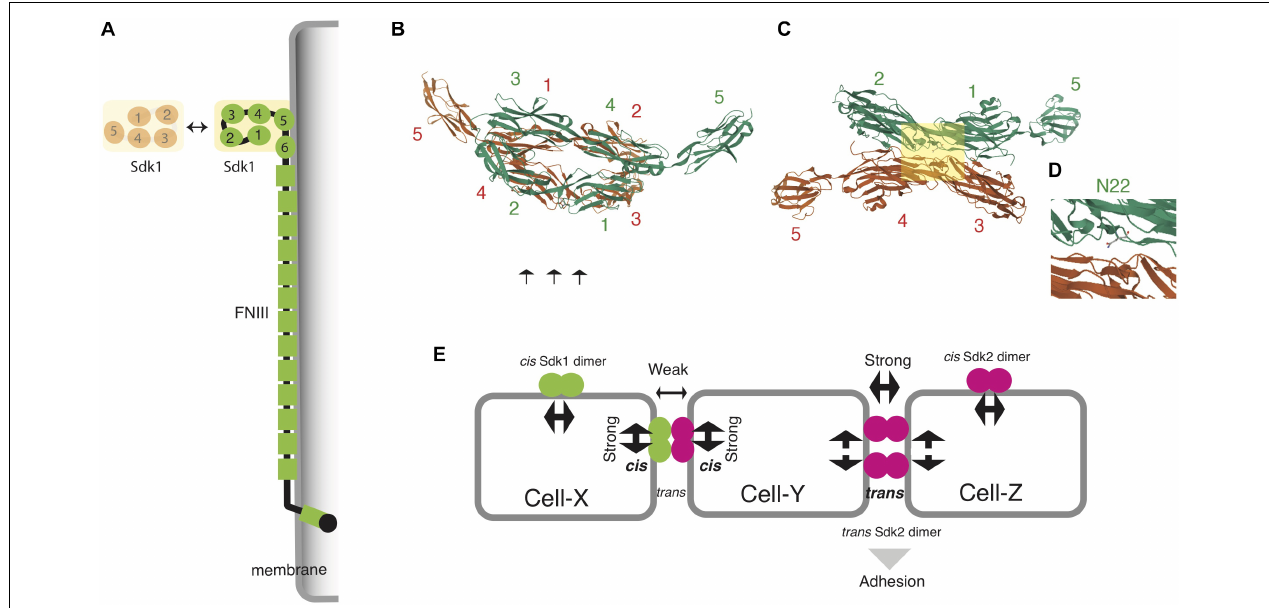
FIGURE 2 | Structural basis of homophilic adhesion in Sdks. (A) A horseshoe-like structure of N-terminal Ig domains (Ig1-4) is responsible for homophilic adhesion. Ig5, Ig6, and FNIII domains are associated with plasma membranes (Tang et al., 2018). (B) The crystal structure of Sdk1 Ig1-Ig5 homodimers (https://www.rcsb.org/3d-view/5K6W) (Goodman et al., 2016). Four Ig domains of the first molecule (green) faces to those of the second molecule (red) in a back-to-back anti-parallel manner: Ig1 to Ig3, and Ig2 to Ig4. (C) The lateral view of (B) (arrows in B ) to display the interactive interface. (D) The squared area in (C)